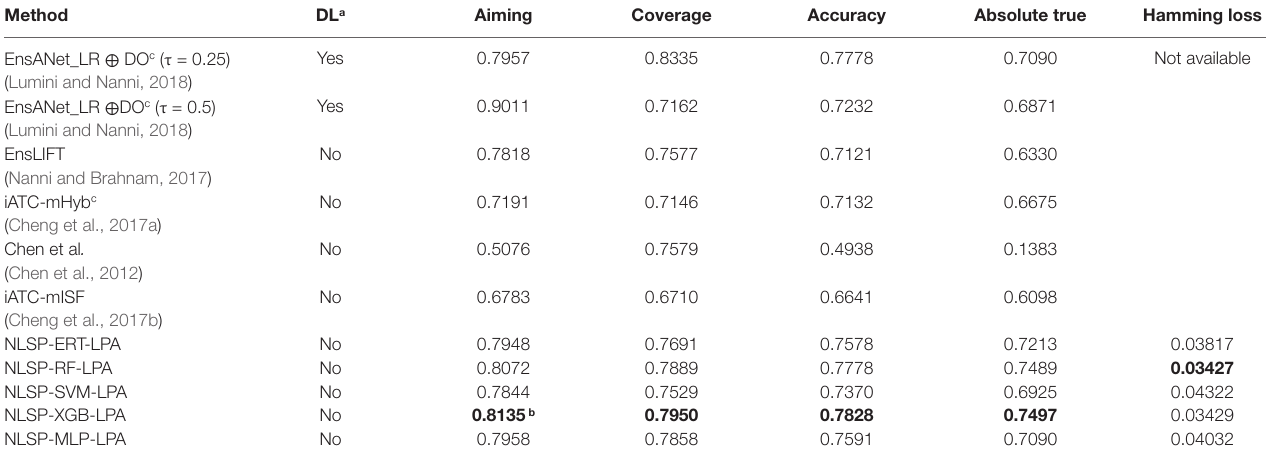
TABLE 1 | Comparison with other state-of-the-art multilabel predictors.